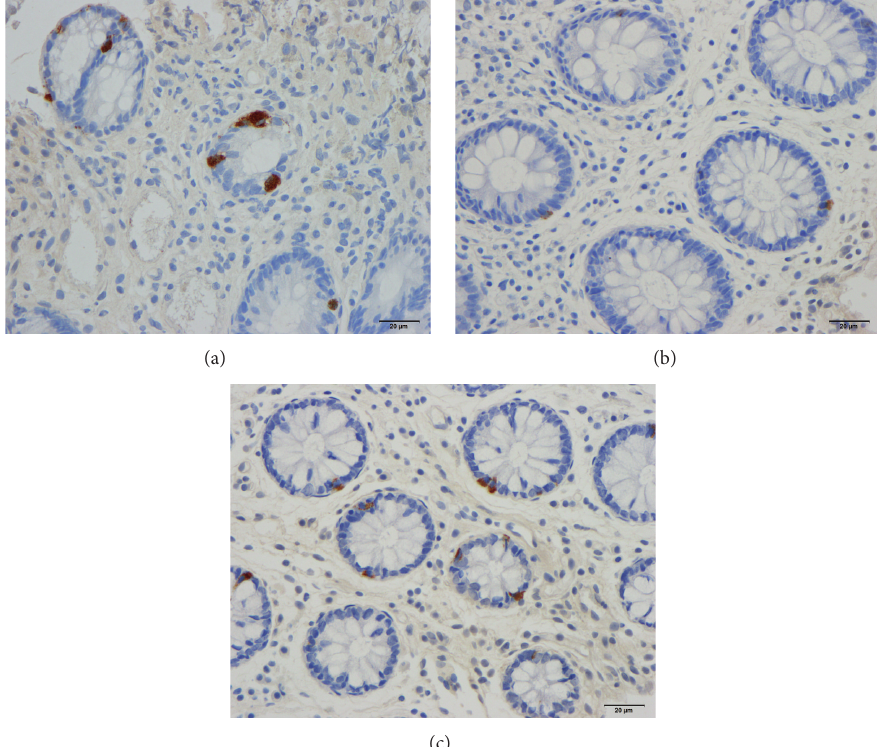
Figure 2: CgA-immunoreactive cells in the total colon of a control subject (a) and of an IBS patient before (b) and after (c) receiving dietary guidance.